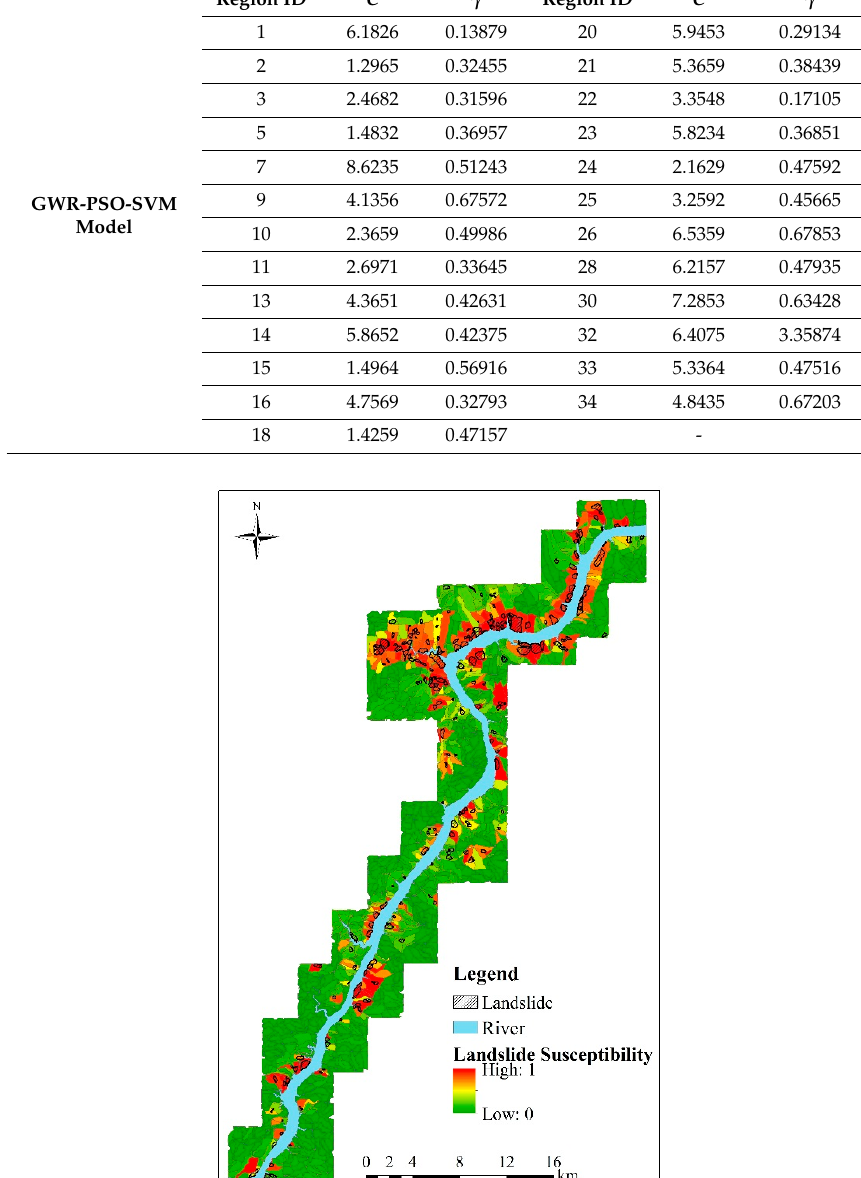
Table 8. Table 8. The parameter settings of C and GWR-PSO-SVM model.